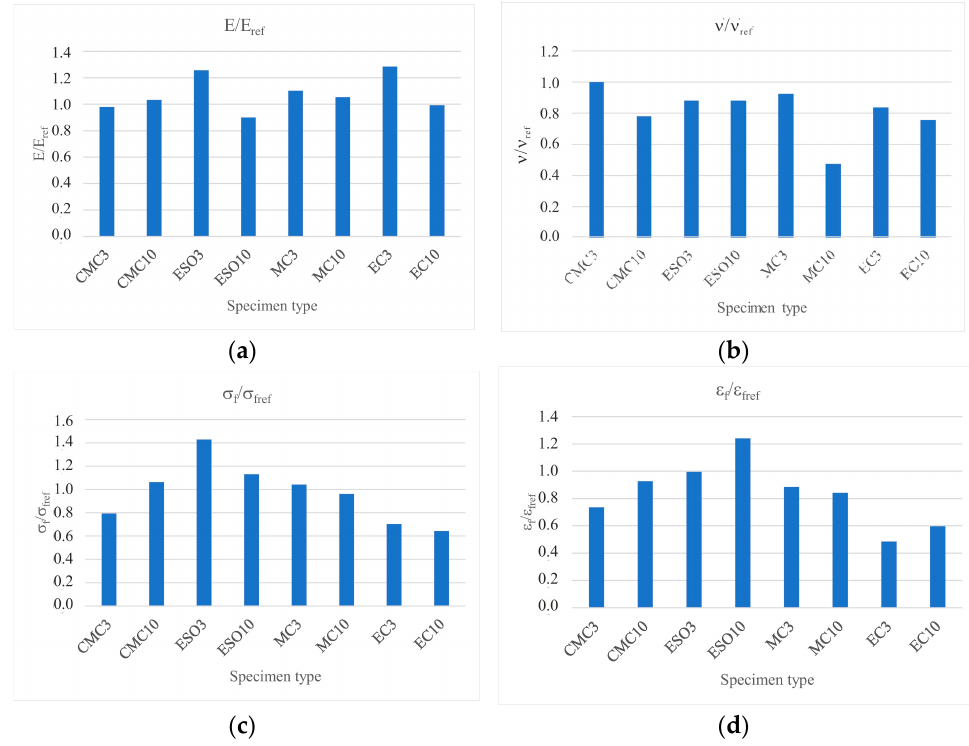
Figure 12. Ratios of ( a ) E/E ref , ( b ) ν / ν ref , ( c ) σ f / σ fref and ( d ) ε f / ε fref .